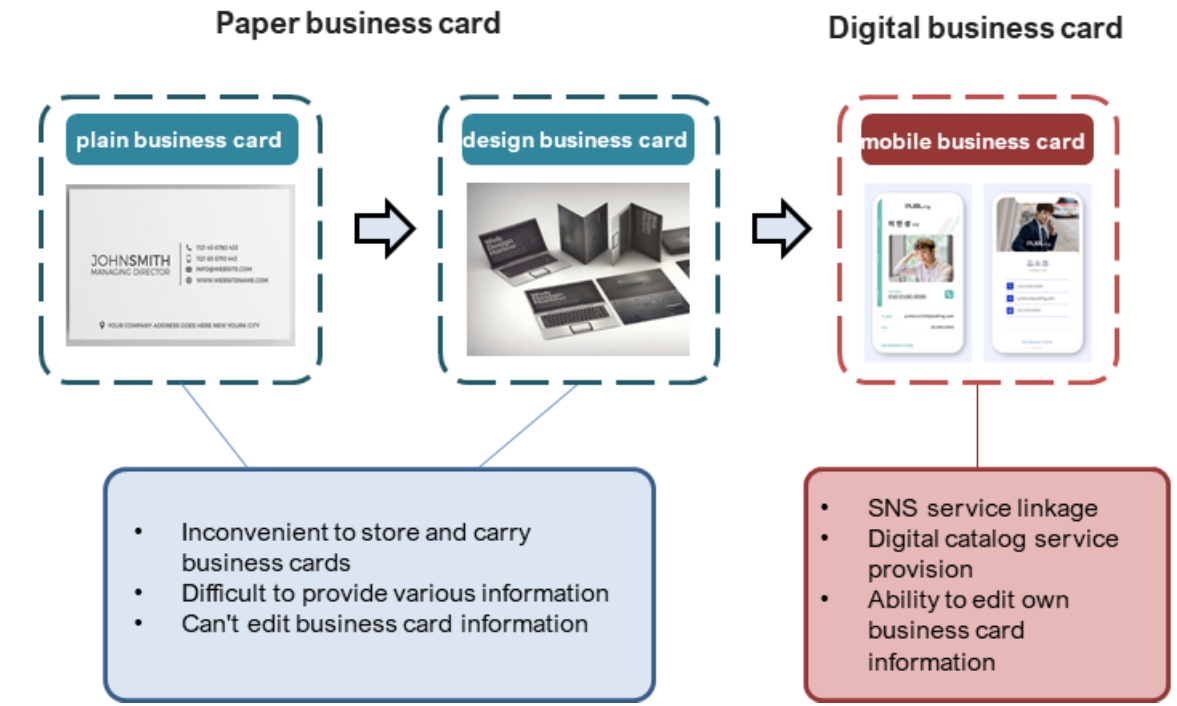
Figure 3. Paper business cards and digital business cards.